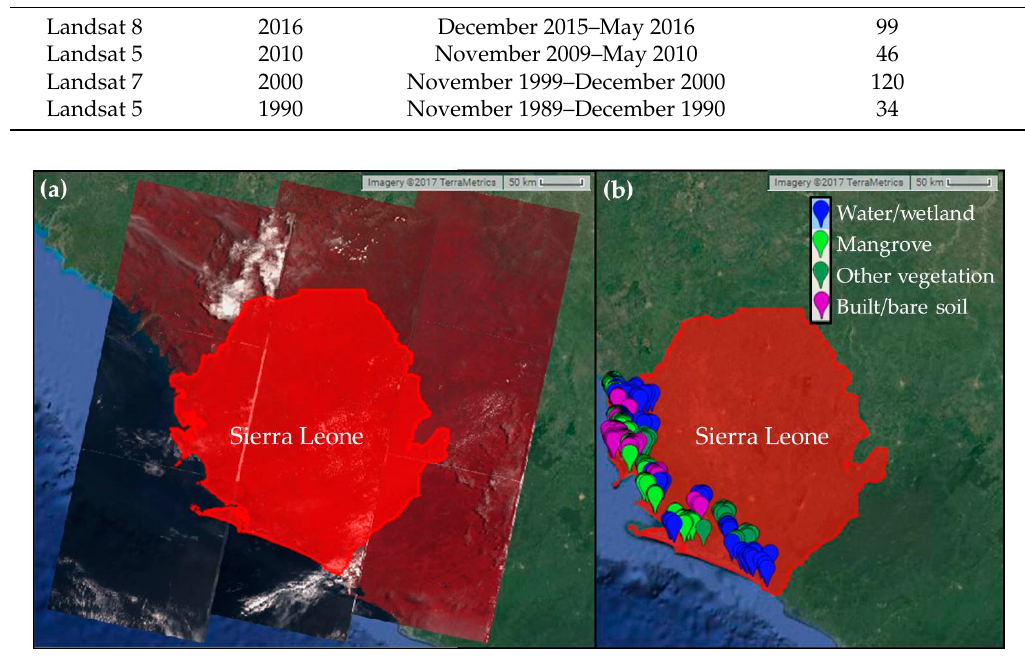
Figure 2. Maps from Google Earth Engine (GEE) showing: ( a ) Landsat footprints covering Sierra Leone; and ( b ) location of validation points used for accuracy assessment for the 2016 classified map.